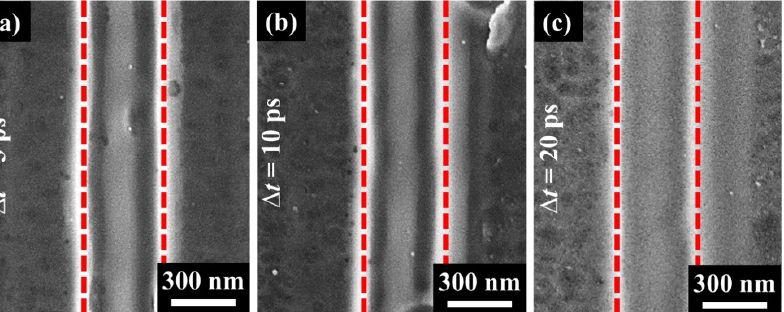
Figure 4. Formation of the sole long nanowire structure inside the groove with varying time delay of laser sub-pulses. ( a ) Δ t = 3 ps, ( b ) Δ t = 10 ps, ( c ) Δ t = 20 ps. The total incident laser energy fluence is F = 30 mJ/cm 2 , and the scanning speed is v = 0.3 mm/s.